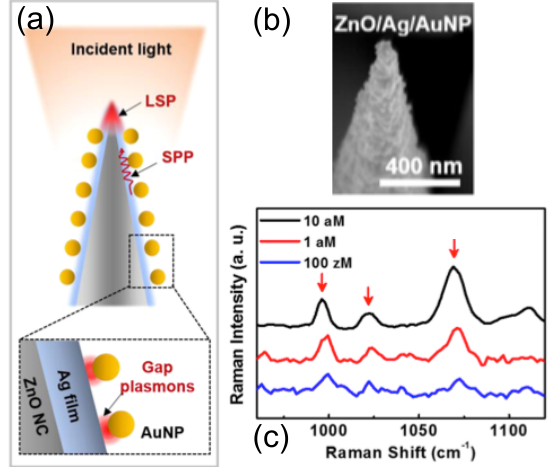
Figure 5. ( a ) scheme of the detection principle of SERS nanosensor (Electric field located at the tip and at the particle–film gap; SPP = Surface Plasmon Polariton and LSP = Localized Surface Plasmon); ( b ) SEM image of an AuNPs/Ag/ZnO nanocone; ( c ) SERS spectra of thiophenol molecules adsorbed on AuNPs/Ag/ZnO nanocones at the trace level (for three very low concentrations). All are reprinted with permission from [82], copyright 2015 American Chemical